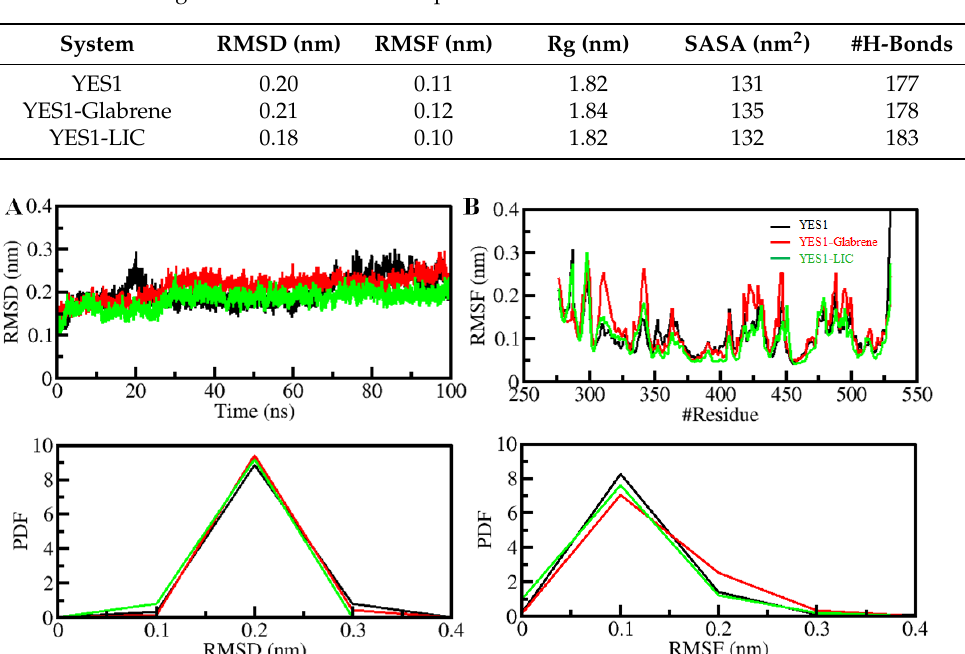
Table 5. The average values of different MD parameters calculated after 100 ns simulations.